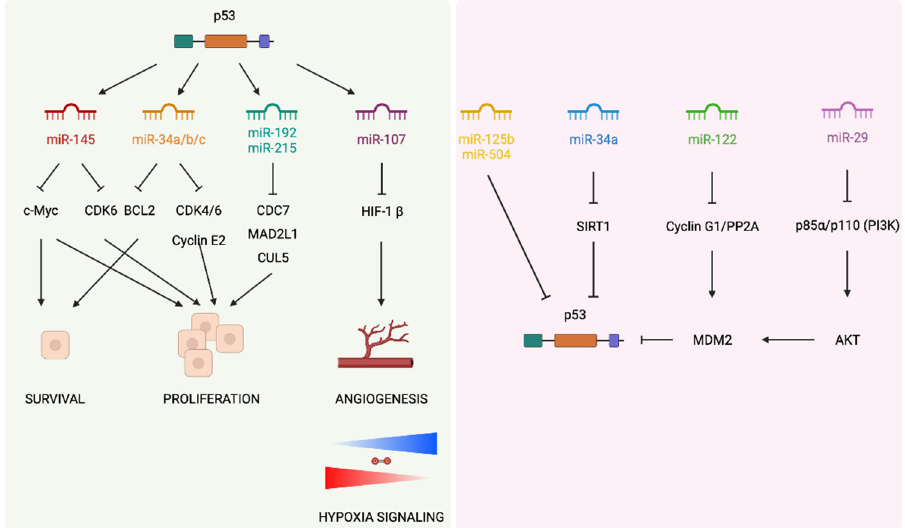
Figure 3. p53 regulates the expression of several miRNAs for further regulation of various processes of the metastatic dissemination (left side). microRNAs might also be negative regulators of p53 (right side).